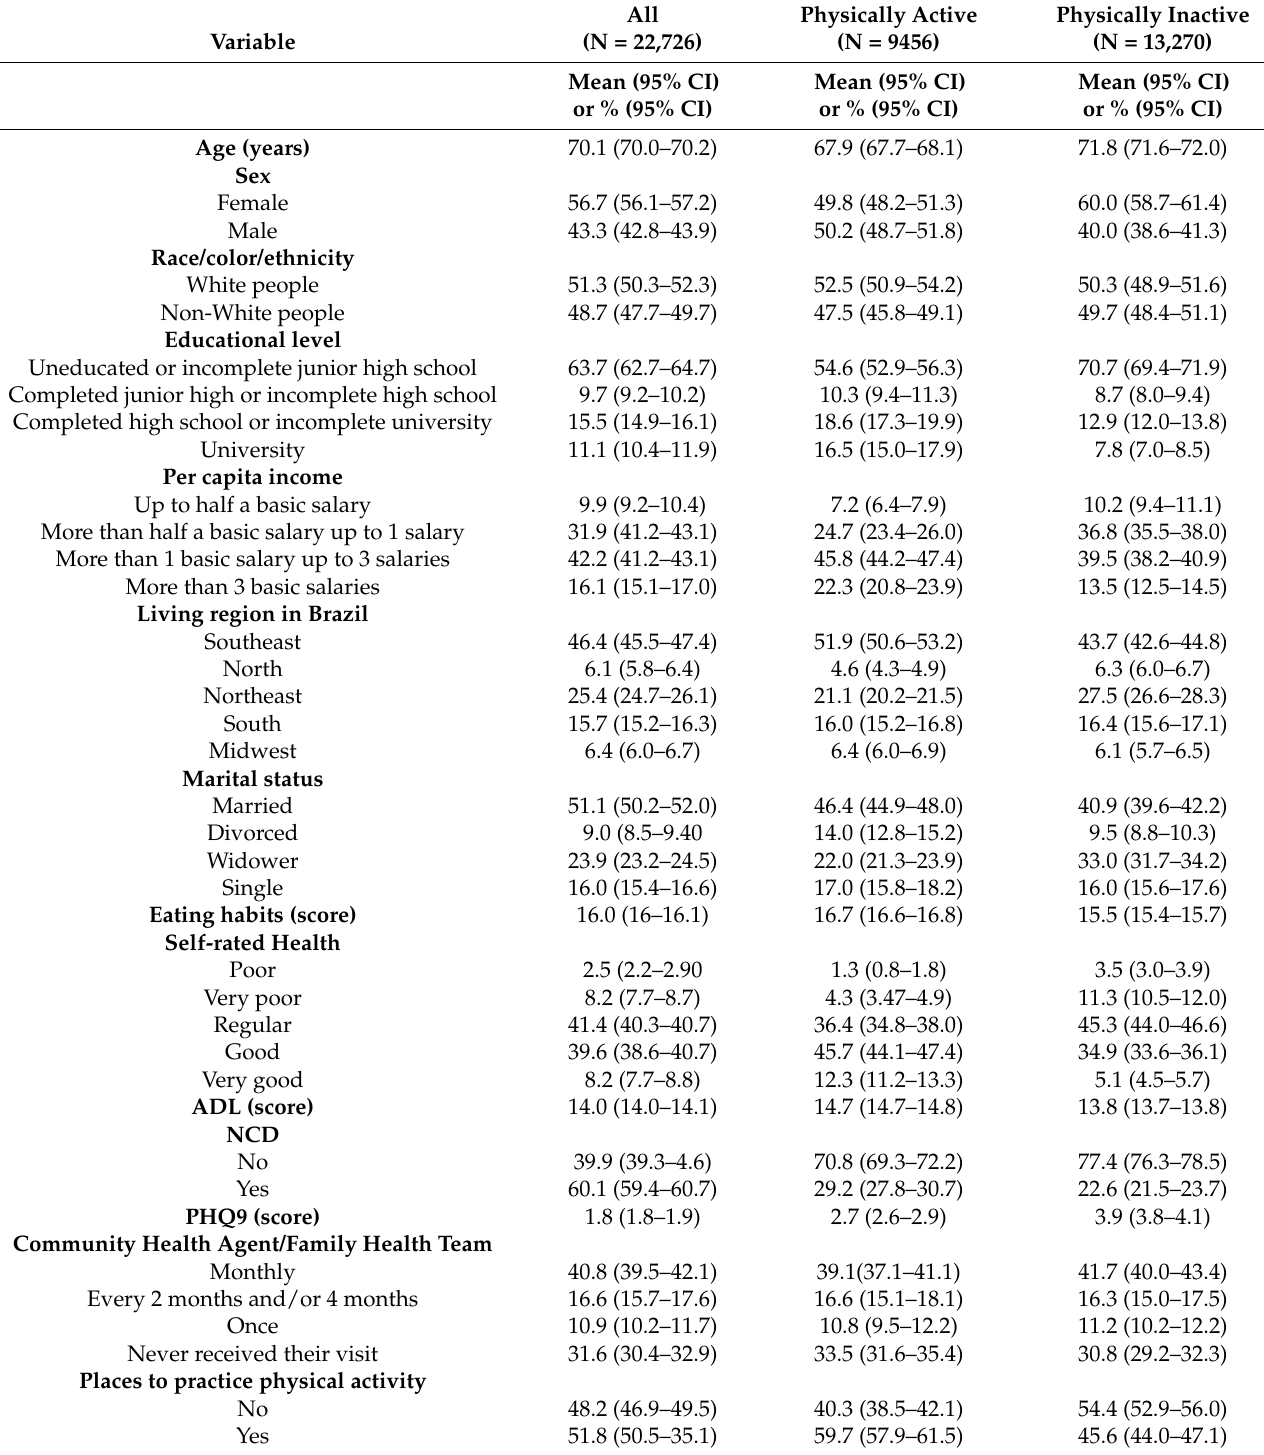
Table 2. General characteristics of the sample (NHS,